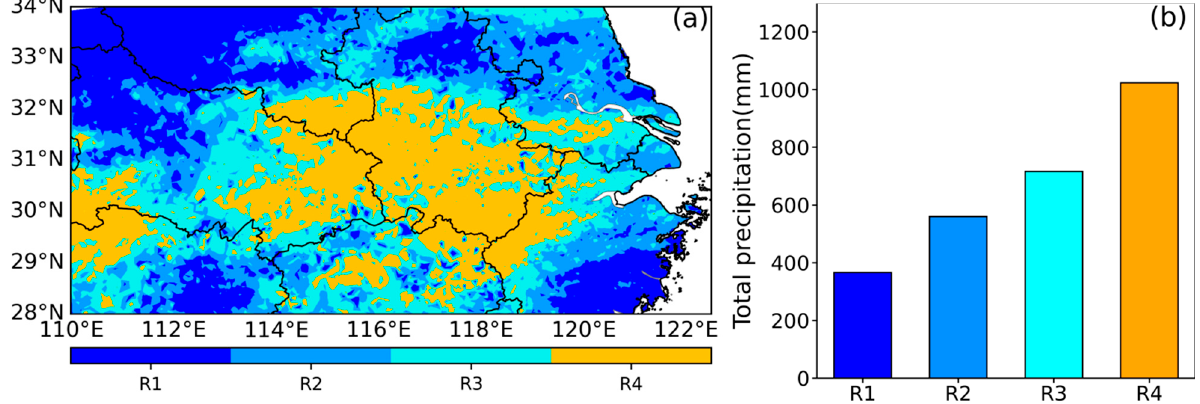
Figure 3. ( a ) Spatial distribution of four sub-regions within the Meiyu monitoring area. ( b ) Comparison of the differences in the average accumulated precipitation of the four sub-regions during the Meiyu precipitation period in 2020.